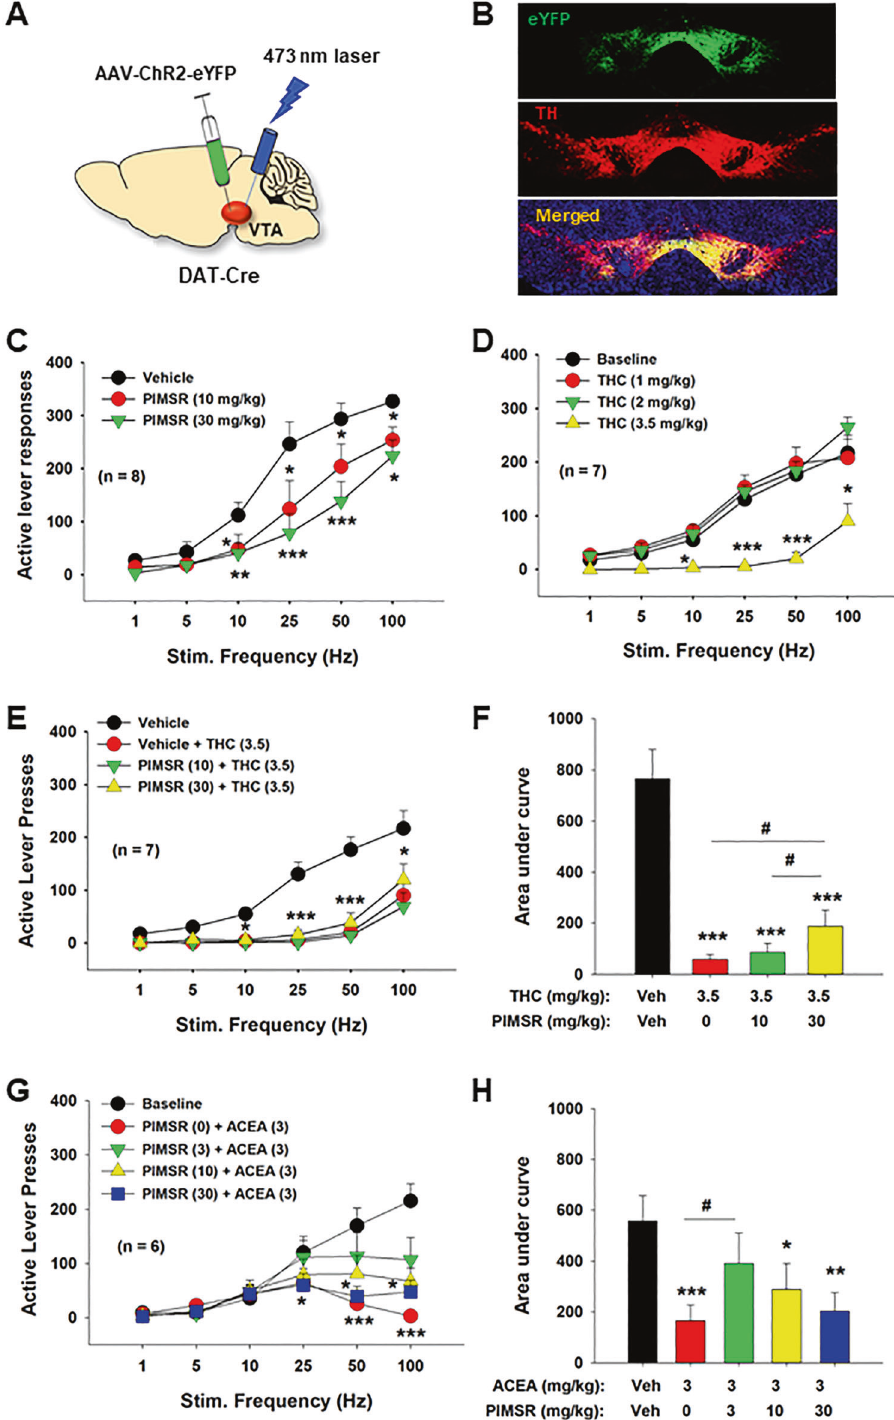
Fig. 6 Effects of PIMSR on oICSS maintained by optical stimulation of VTA DA neurons in DAT-Cre mice. A A diagram showing the experimental methods for oICSS. B Representative images of TH-immunostaining (red) and fl uorescent ChR2-eYFP expression (green) in the VTA, illustrating TH and ChR2-eYFP colocalization in VTA DA neurons. C Systemic administration of PIMSR inhibited optical ICSS ( n = 8). D Δ 9 -THC alone also inhibited oICSS at a high dose (3.5 mg/kg) and shifted the stimulation-response curve downward ( n = 7). E Pretreatment with PIMSR failed to signi fi cantly alter Δ 9 -THC-induced reduction in oICSS ( n = 7). F However, the AUC assays for the data shown in E revealed a signi fi cant reduction in Δ 9 -THC ’ s action on oICSS after PIMSR pretreatment. G PIMSR also attenuated ACEA-induced reduction in oICSS ( n = 6). H The AUC assays for the data shown in G revealed a signi fi cant reduction in ACEA action on oICSS after 3 mg/kg PIMSR pretreatment. * p < 0.05, compared to vehicle at each stimulation frequency. # p < 0.05, com p ared to Δ 9 -THC or ACEA treatment group.